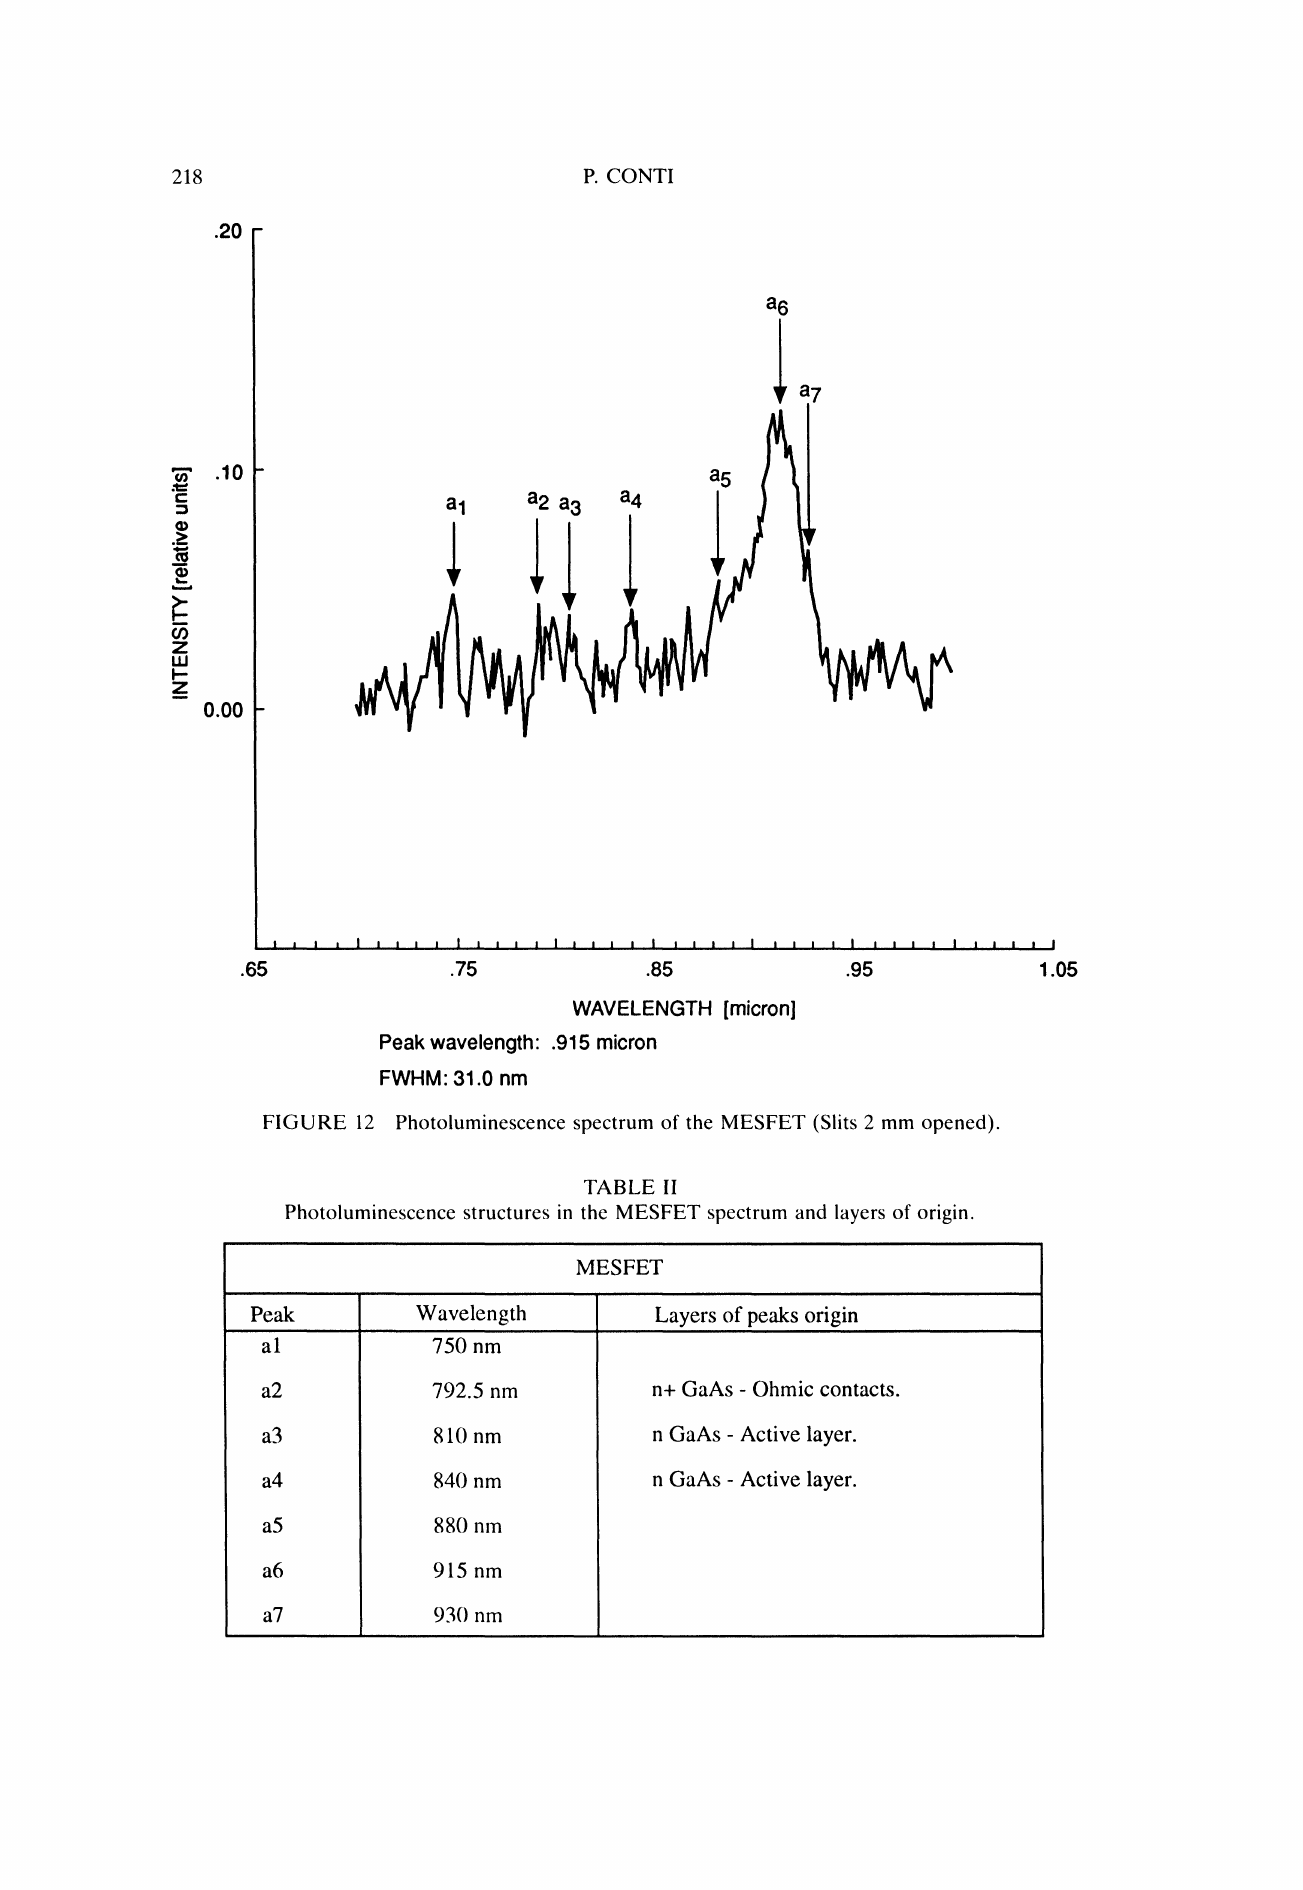
Photoluminescence structures in the MESFET spectrum and layers of